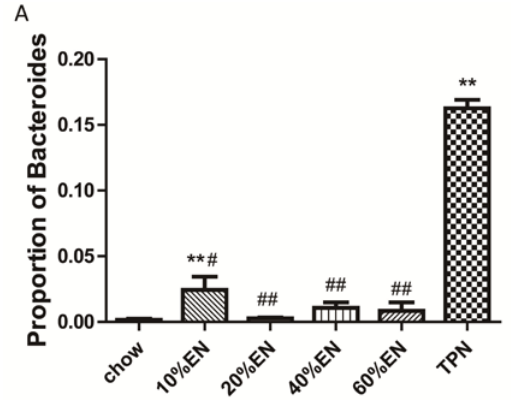
Figure 7. Cont. Figure 7. Cont